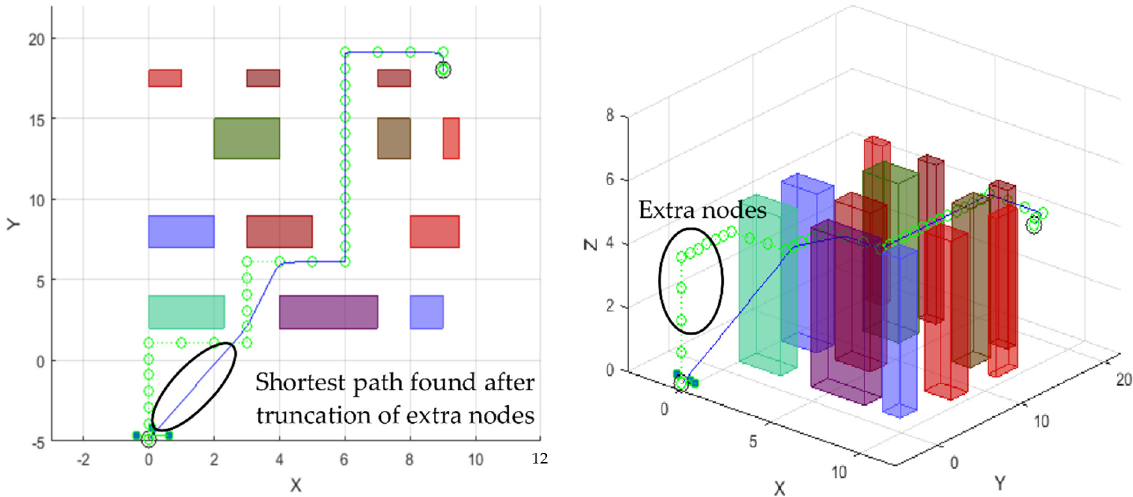
Figure 8. Extra node truncation followed by optimal trajectory generation.